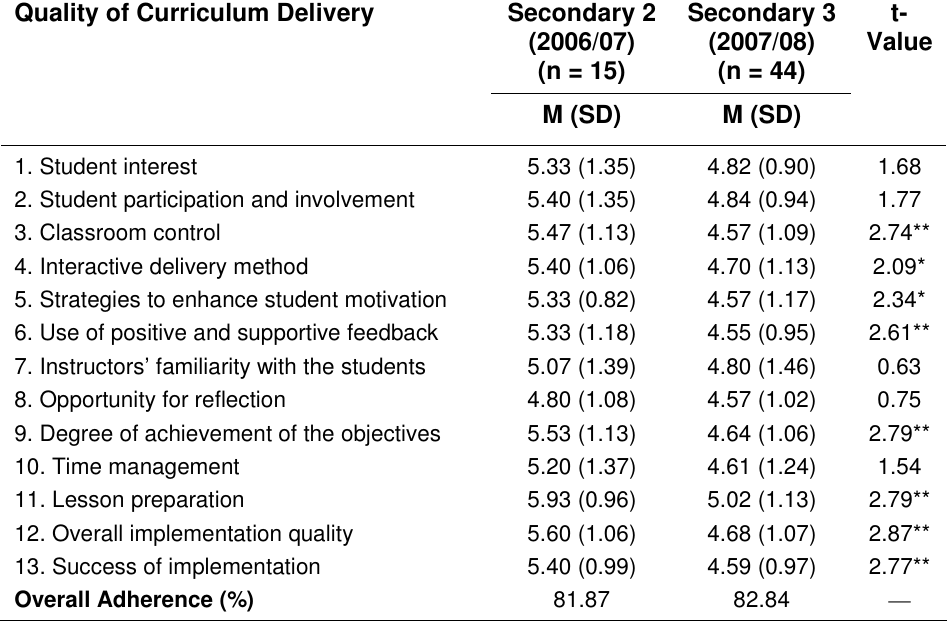
Average Rates of Quality of Curriculum Delivery and Overall Adherence in Secondary 2 and 3 Programs of the Experimental Implementation